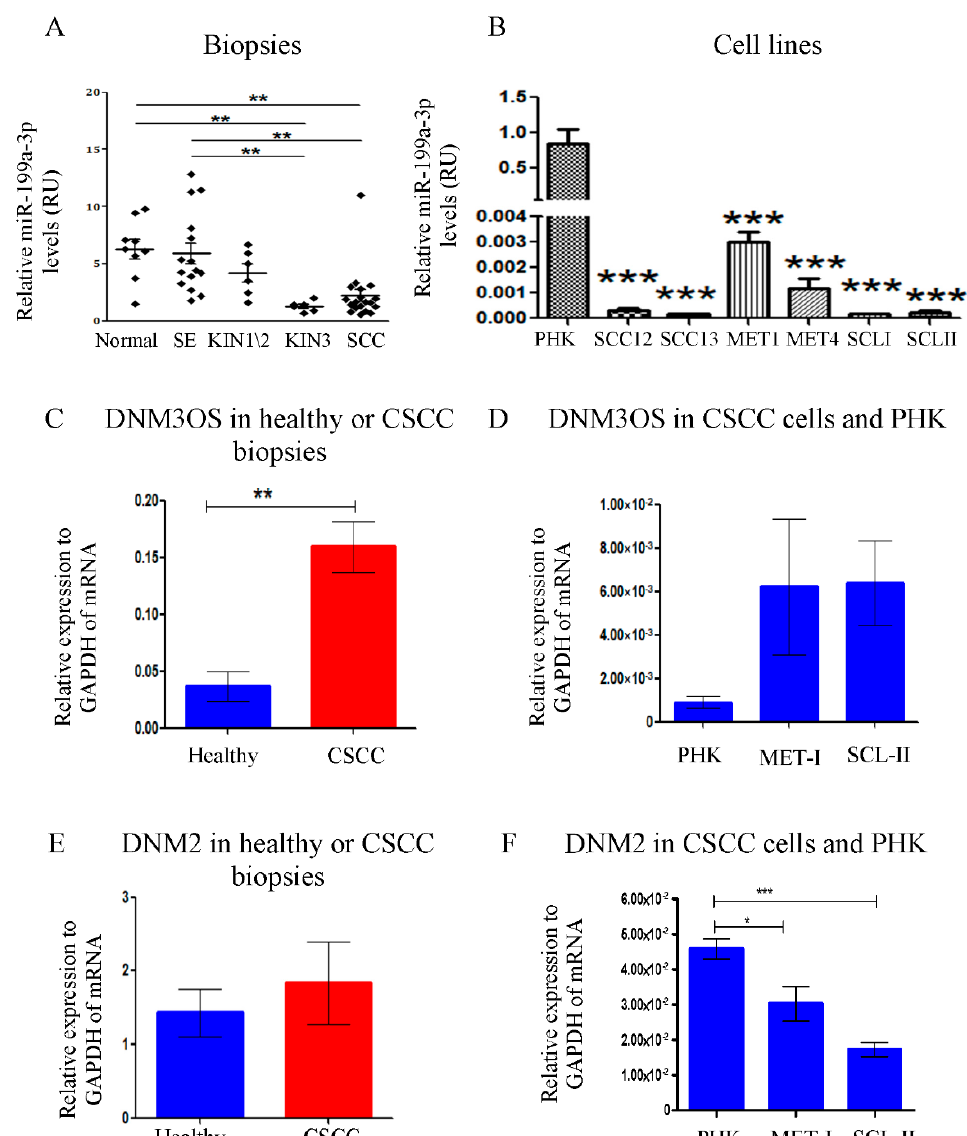
Figure 1. miR-199a-3p expression in different development stages towards CSCC and in CSCC cell- lines. ( A ) miR-199a-3p expression along different stages in the malignant evolution of CSCC. Results are normalized to Rnu43 (SNORD43). Each diamond represents an individual sample. The average is denoted by a horizontal line (the number of samples tested in each stage is written in parentheses below). ( B ) The expression levels of miR-199a-3p in various CSCC cell lines and PHK culture as assessed by qRT-PCR and normalized to Rnu48. ( C ) The expression of DNM3OS in healthy skin biopsies compared to CSCC biopsies ( D ) The expression of DNM3OS in PHK compared to CSCC cell lines. ( E ) The expression of DNM2 in healthy skin biopsies compared to CSCC biopsies. ( F ) The expression of DNM2 in PHK compared to CSCC cell lines. Error bars show ± SEM. p -values are calculated via one-way ANOVA, and Tukey’s method was implemented as a correction for multiple comparisons. ** p < 0.01, *** p < 0.001. p -values are calculated via One-Way ANOVA, and